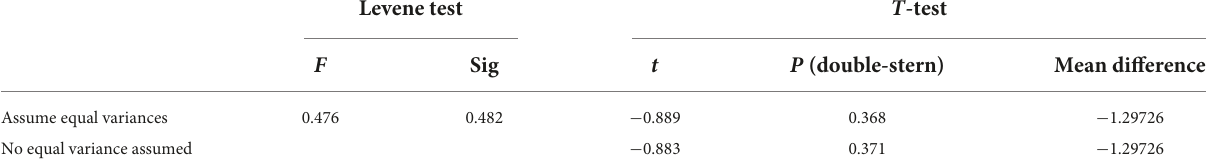
TABLE 1 Independent test results.